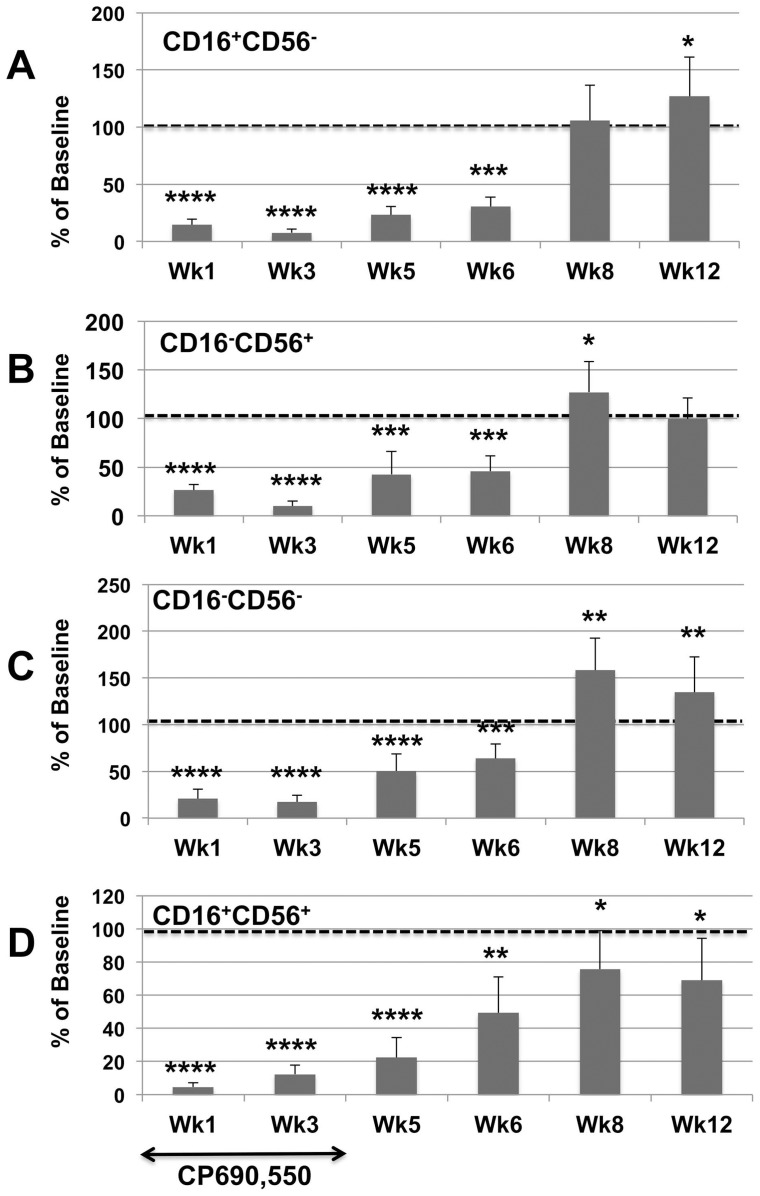
Frequencies of the 4 major subset of the CD3−/CD8+/NKG2a+ NK cells.Aliquots of the same PBMC from the 6 SIV infected monkeys as used under Fig. 2 were also analyzed for the frequencies of the 4 major subset of the CD3−/CD8+/NKG2a+ NK cells. The data is once again expressed as the mean +/− S.D. of the baseline values from individual monkeys. A) The % change from baseline values for the CD16+/CD56− (cytolytic subset) B) The % change from baseline for the CD16−/CD56+ (major cytokine synthesizing subset) C) The % change from baseline in the CD16-/CD56- subset and D) The % change from baseline of the CD16+/CD56+ subset. The statistical differences are denoted by asterisks and reflects * (p<0.01), ** (p<0.05), *** (p<0.03) and **** (p<0.0001).